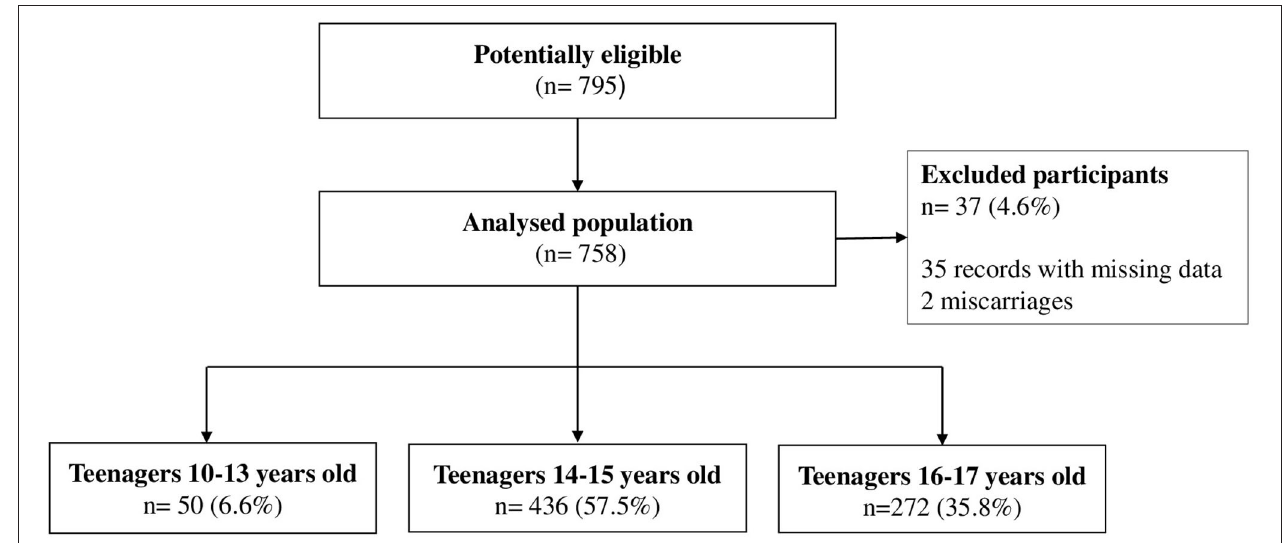
FIGURE 1 | Flowchart representing the sample